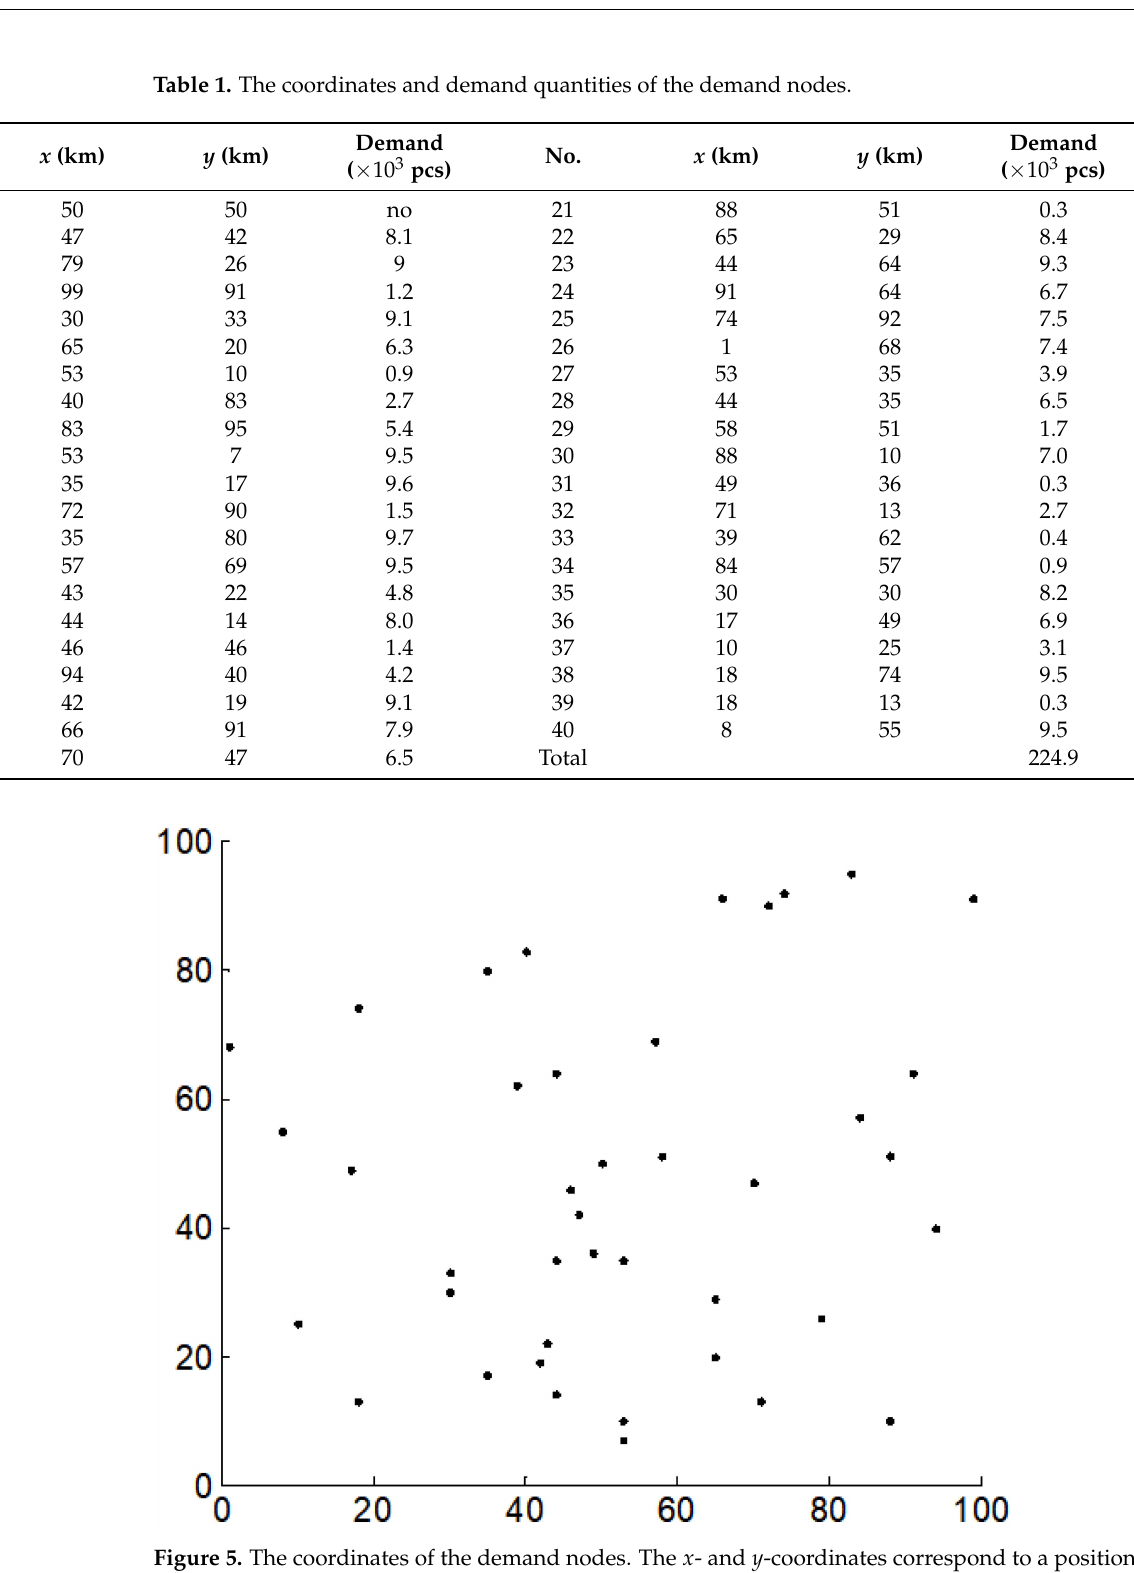
Figure 5. The coordinates of the demand nodes. The x - and y -coordinates correspond to a position on a